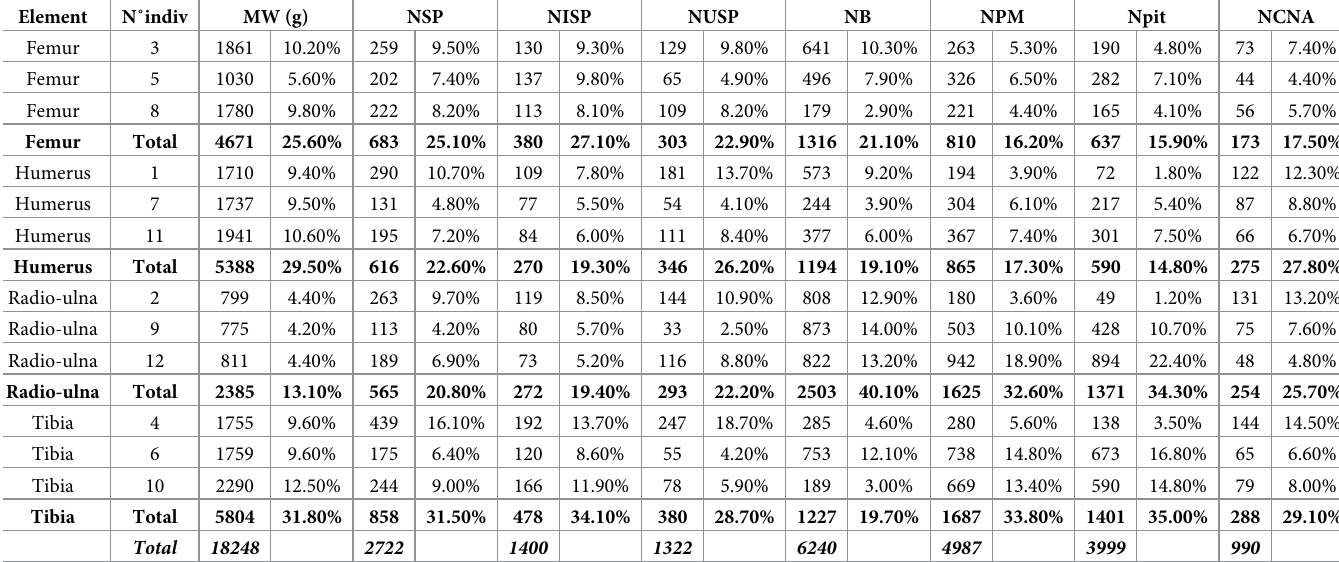
Table 4. Results of analyses of long bone remains.